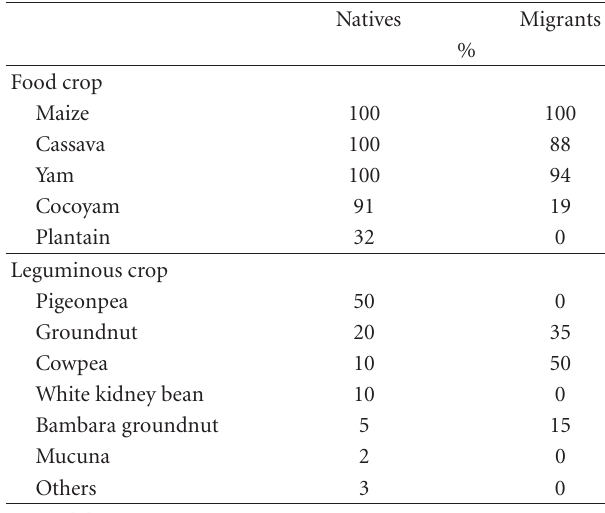
Table 1: The most important food crops and proportion of land allocated to leguminous crops by native and migrant farmers in Asuoano in